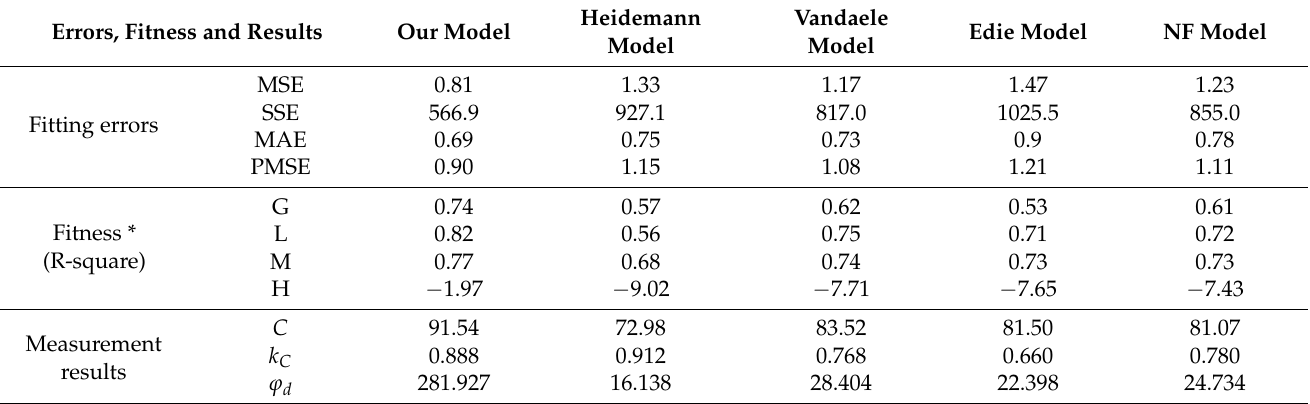
Table 5. The fitting errors index of different models. Numbers in bold indicate the minimum error or